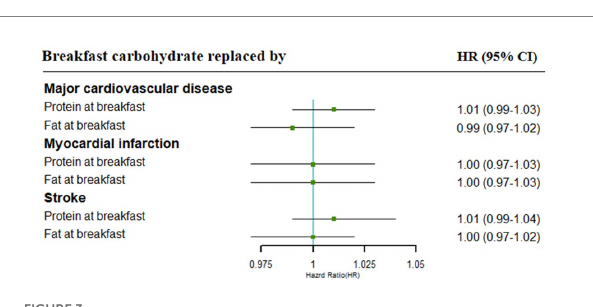
FIGURE 3 Cardiovascular risk associated with isocaloric (5% of energy) replacement of carbohydrates with other specific macronutrients. Adjustments included age, gender, urban or rural location, education level, income, physical activity, smoking status, alcohol intake, BMI, history of hypertension, diabetes, energy intake at breakfast, SFA, grains, vegetables, and dietary